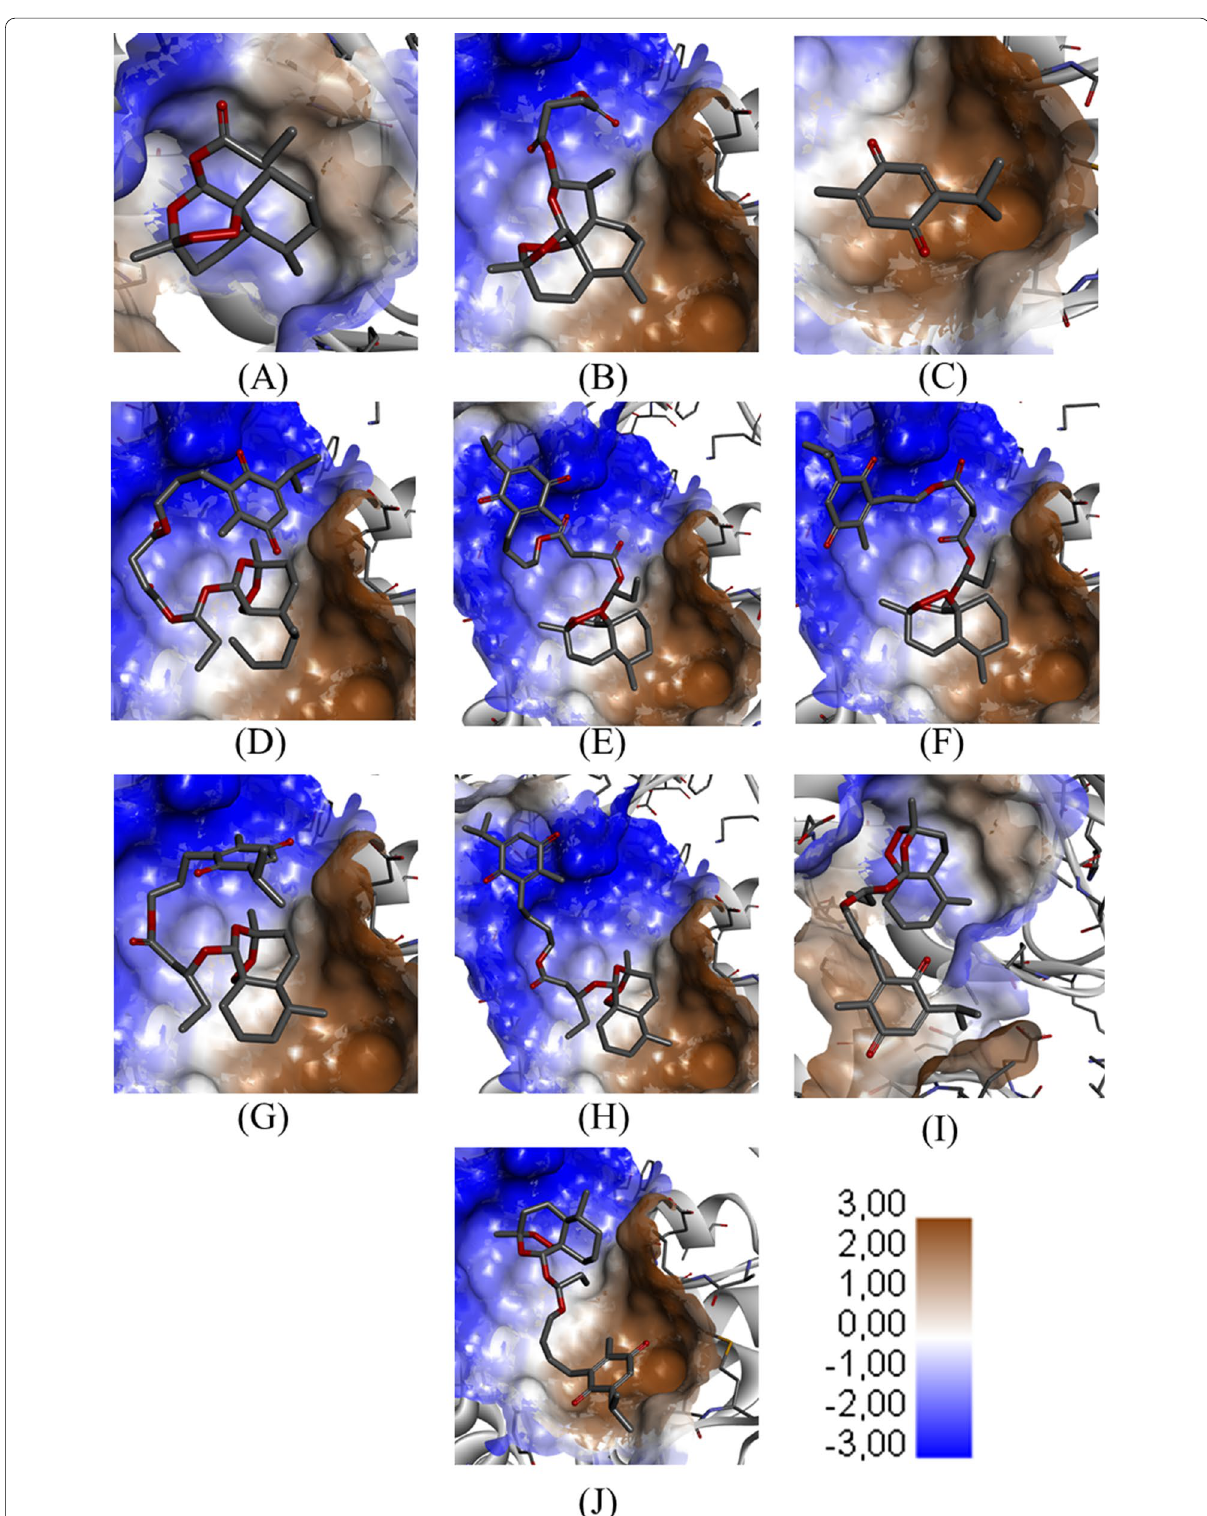
Fig. 10 Surface map of ART-THY parental and hybrid compounds with Mpro. A Artemisin; B artesunic acid; C thymoquinone; D T1; E T2; F T3; G T4; H T5; I T6; J